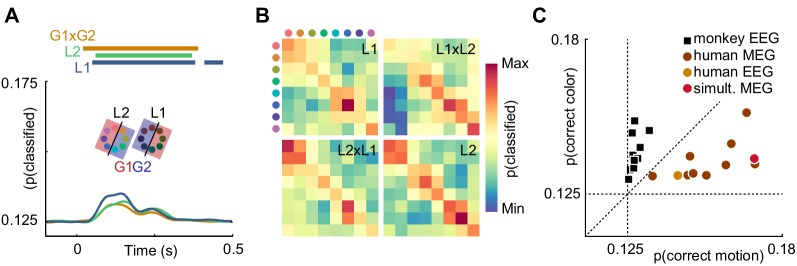
Control experiments.(A) Time-resolved classifier accuracy. Accuracy is highest when trained and tested on high-luminance stimuli (L1), and lower when trained and tested on low-luminance stimuli (L2). Training on half of the color space in low luminance, and half of the color space in high luminance, and testing on the remainder (G1 x G2), results in accuracy comparable to the low-luminance stimuli alone. (B) Confusion matrices for low-luminance and high luminance stimuli, as well as classifiers trained on low-luminance and tested on high-luminance stimuli and vice versa (L1 x L2, L2 x L1). (C) Maximum color and motion classifier accuracies for all individual sessions. Color is better classified in monkey EEG, motion is better classified in human MEG and EEG. Simultaneously recorded human MEG and EEG results in overall higher accuracy in MEG, but more motion than color information in both.